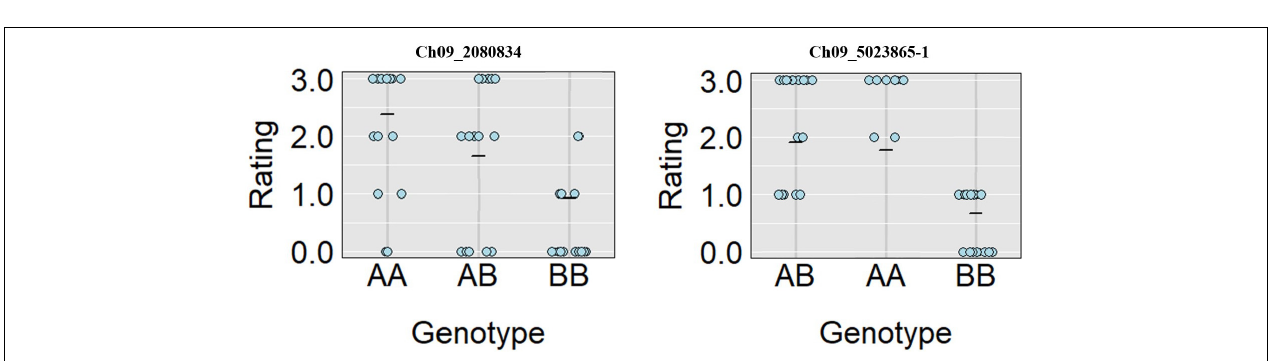
FIGURE 3 | Genotype plots for Ch09_2080834 and Ch09_5023865-1 SNPs showing the corresponding phenotypic distribution in the F 2 population.